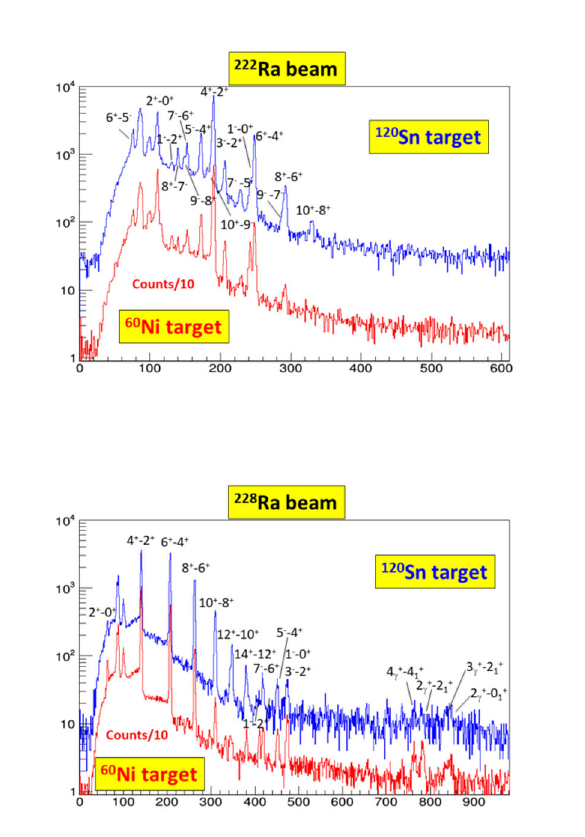
Figure 5. Spectra of γ -ray transitions in 222 Ra (upper) and 228 Ra (lower) following bombardment of 120 Sn (blue) and 60 Ni (red) targets. The γ -rays are corrected for Doppler shift assuming that they are emitted from the scattered